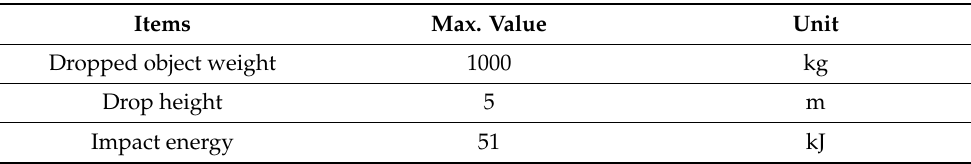
Table 4. Experimental facility